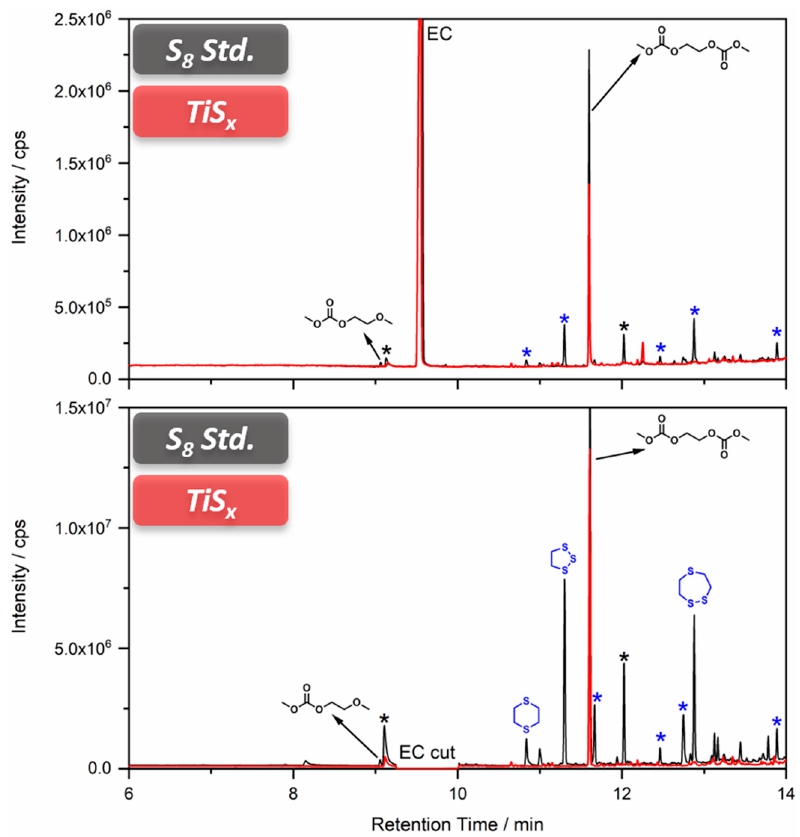
Figure 4. Overlay of the chromatograms obtained from carbonate-based electrolytes regained from sulfur-based cells. Measurements with 1:100 split ratio top and 1:10 bottom. Chromatograms connected to cells with standard sulfur cathodes are shown in black; titanium sulfide cells are depicted in red. Signals corresponding to aging products with carbonate origin are marked in black; aging products containing sulfur species are colored in blue. The structures of compounds with positive structural elucidation are shown at their respective signal. Signals without complete structural elucidation are marked with asterisks.